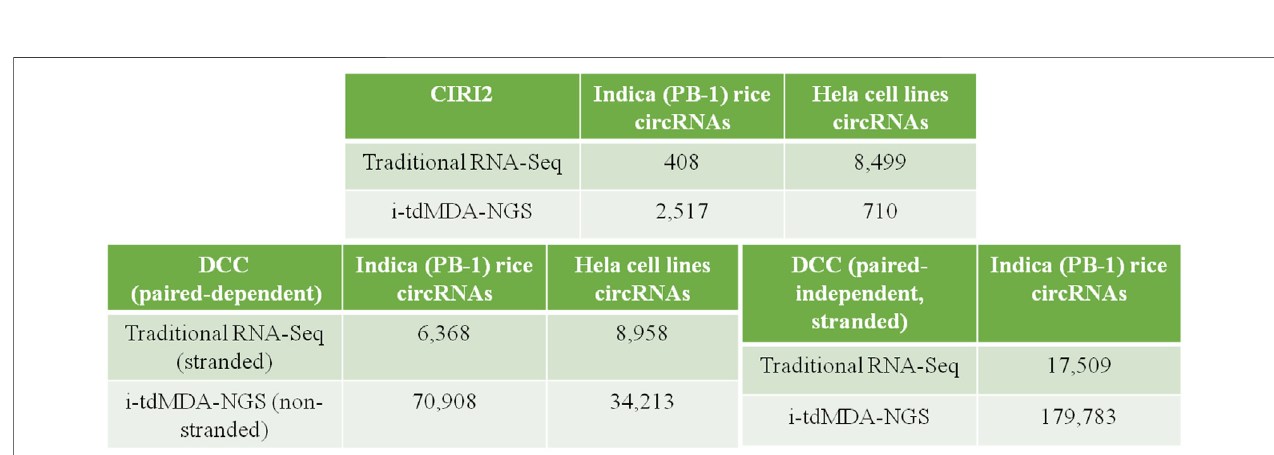
FIGURE 2 | CircRNA identi fi cation by DCC and CIRI2. List showing circRNAs identi fi ed by traditional RNA-Seq and i-tdMDA-NGS using the DCC and CIRI2 computational pipelines from Indica rice and HeLa cell lines.